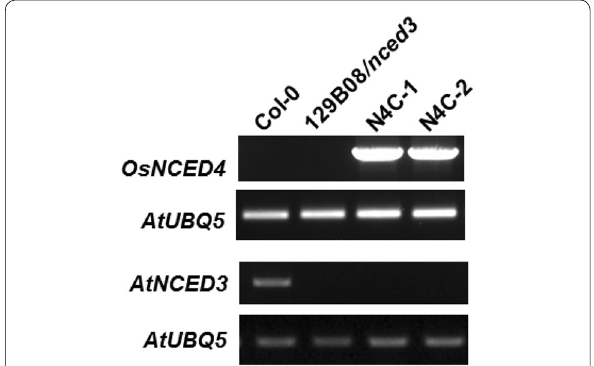
Fig. 1 RT‑PCR analysis of native AtNCED3 and transgenic OsNCED4 expression in Arabidopsis plants; Col‑0, 129B08/ nced3 mutant, and two OsNCED4 ‑overexpressing (N4C) transgenic